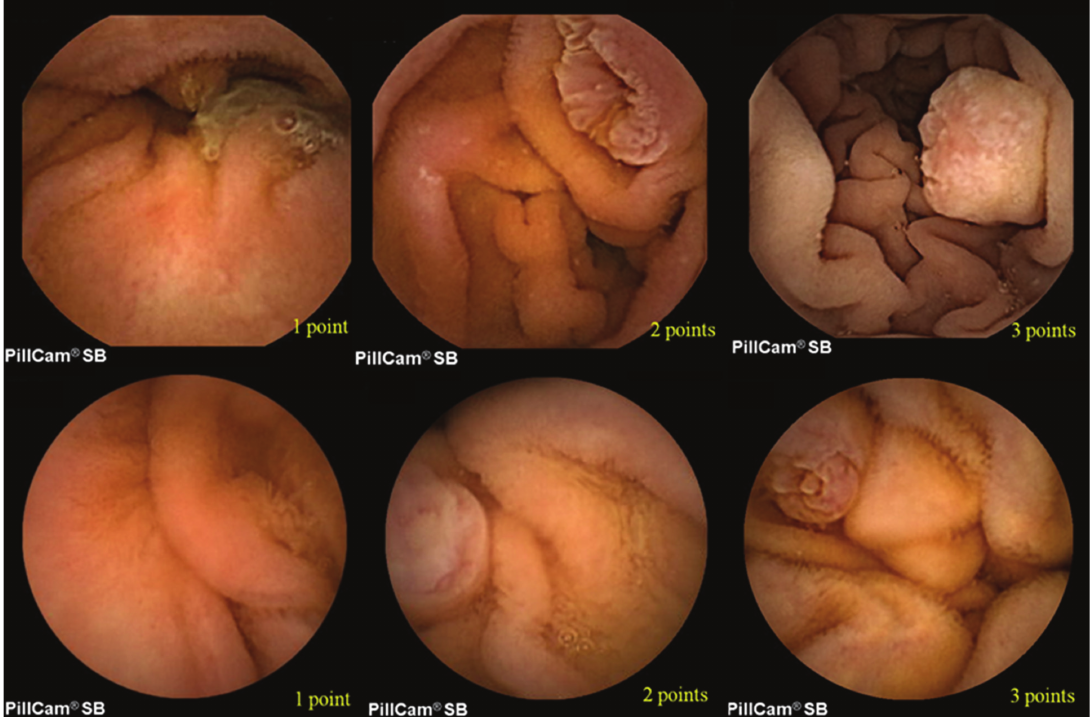
Figure 1: Representative images and scorings of papillary outline (marked on bottom right) of each capsule endoscopy (upper and lower panel for SB2 and SB, resp.). The octangular outline of SB2 images were hidden with black-colored paper in order not to be discerned by experienced